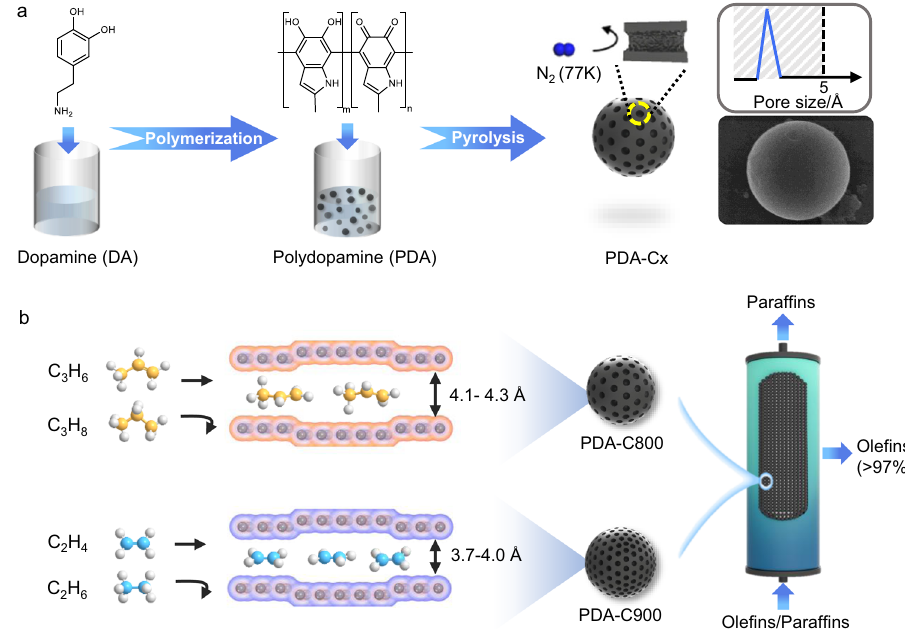
Fig. 1 | Formation process and gas sorption properties of PDA-Cx. a Schematic illustration of the synthetic procedure. Dopamine undergoes self-assembly to prepare polydopamine fi rstly and subsequent pyrolysis to synthesize PDA-Cx with narrowly distributed sub-5 Å micropore ori fi ces; b Schematic illustrations of a side view of the poresystem.The small microporeori fi ces inPDA-C800(4.1 – 4.3Å)and